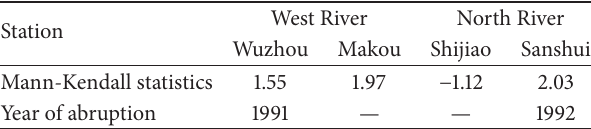
Table 4: Mann-Kendall test results of income flood flow.